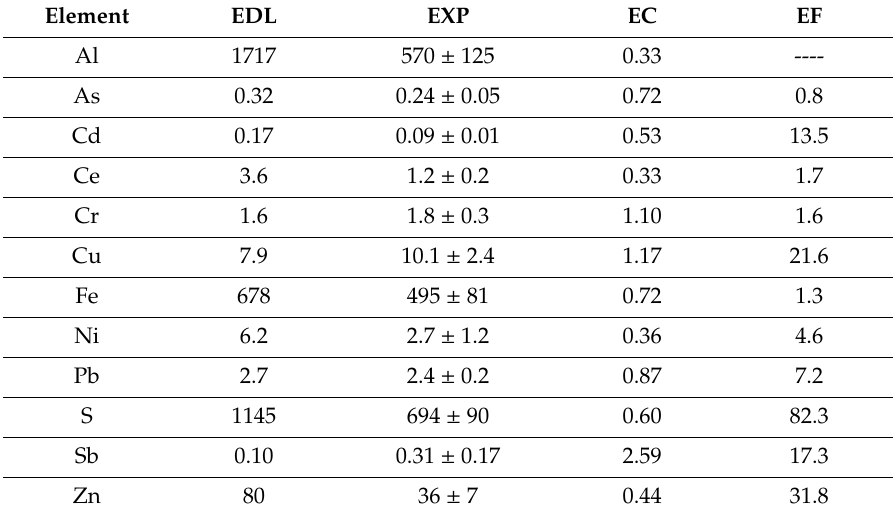
Table 1. E ff ect detection limit (EDL, µ g / g dw) of unexposed (control) samples, mean ( ± SD) values ( µ g / g dw) of exposed samples (EXP), median exposed-to-control ratios (EC), median enrichment factors (EFs).